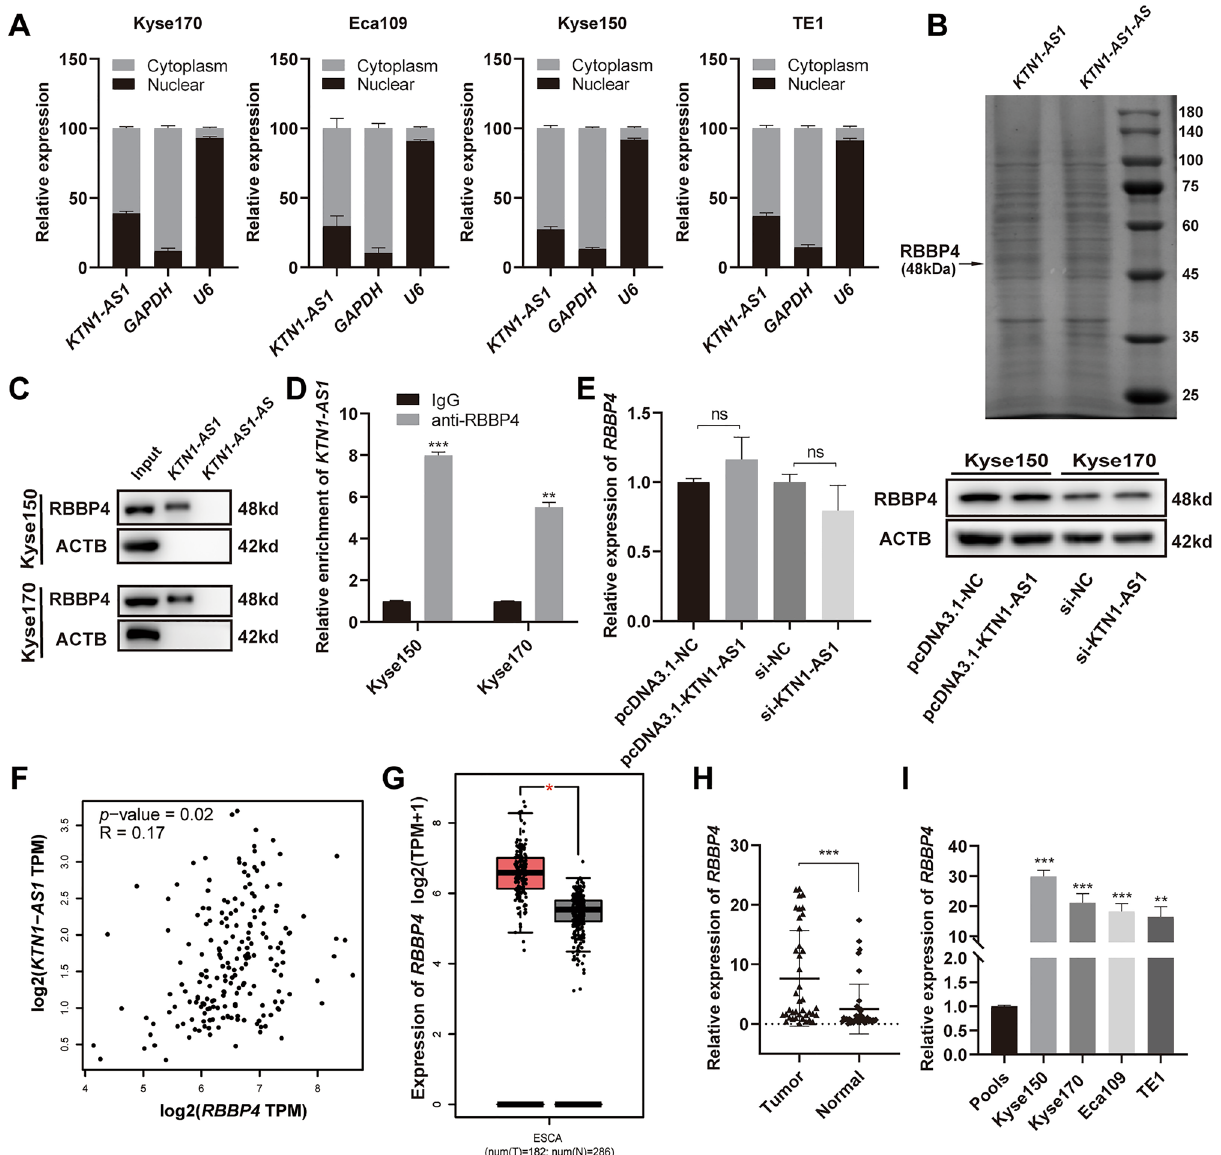
Figure 4. KTN1-AS1 interacts with RBBP4 in the nucleus. ( A ) The subcellular location of KTN1-AS1 in esophageal squamous cell carcinoma (ESCC) cell lines. ( B ) RNA pull-down assay was performed in Kyse150 and Kyse170 cells, and the RNA-related proteins were determined with SDS-PAGE gel and coomassie brilliant blue staining. Original gel image was presented in Supplementary Fig. S5A. ( C ) Western blot assay was performed to detect the specific association between RBBP4 and KTN1-AS1 in Kyse150 and Kyse170 cells. Original western blots were presented in Supplementary Fig. S5B, with blots cut prior to hybridization with antibodies. ( D ) RIP assay showed the interaction between KTN1-AS1 and RBBP4 in Kyse150 and Kyse170 cells. ( E ) The regulation effect of KTN1-AS1 on RBBP4 expression was detected by qRT-PCR and western blot. Original western blots were presented in Supplementary Fig. S5C, with blots cut prior to hybridization with antibodies. ( F ) The relevance between KTN1-AS1 and RBBP4 expression was predicted by the GEPIA database. ( G ) The relative expression of RBBP4 in 182 tumor samples compared with 286 normal samples obtained from the Gene Expression Profiling Interactive Analysis (GEPIA) database. ( H ) The expression levels of RBBP4 in ESCC and the corresponding normal tissues. ( I ) The expression levels of RBBP4 in ESCC cell lines. Error bars are shown as mean ± SD from three replicate experiments (n = 3) (* P < 0.05, ** P < 0.01, *** P <